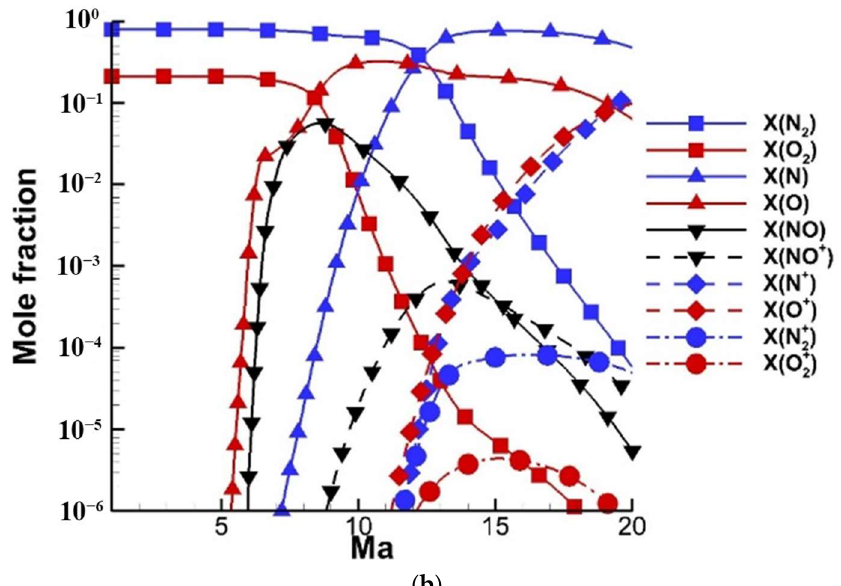
Figure 2. Mole fraction of air species behind normal shock wave varying with Mach number. ( a ) Linear axis. ( b ) Logarithmic axis.